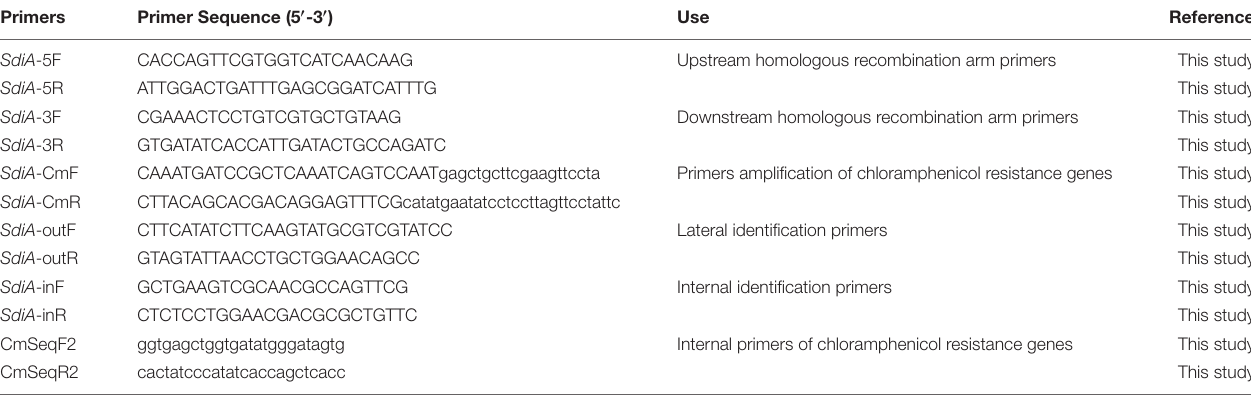
TABLE 1 | Primers used in this study. Primers Primer Sequence (5 (cid:48) -3 (cid:48)